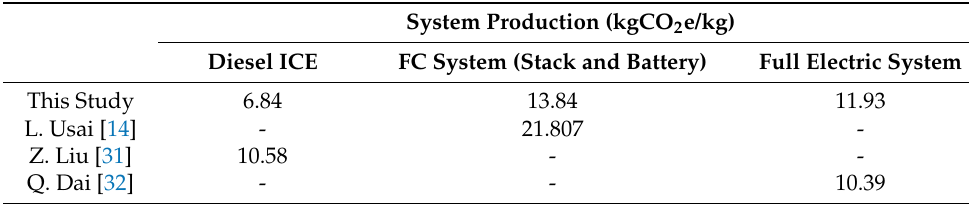
Table 10. Production Emissions